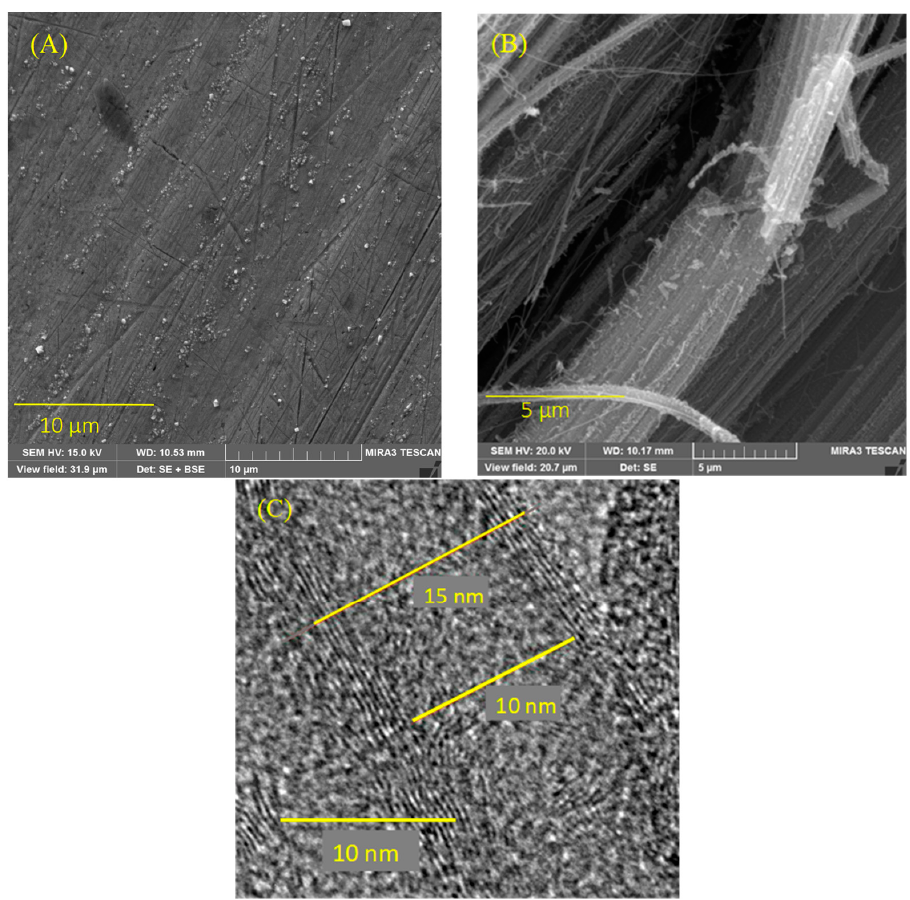
Figure 1. SEM images for silver metal ( A ) and CNTs-Ag electrode ( B ). ( C ) TEM image of MWCNTs grown on the surface of Ag metal using CVD method.